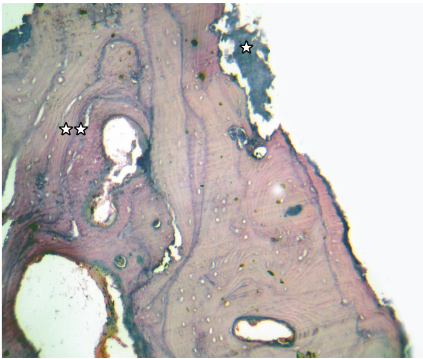
Figure4:Photomicrographofsmear(oilimmersion).Tangledmass of Periodic acid-Schiff (PAS) positive branching filaments.